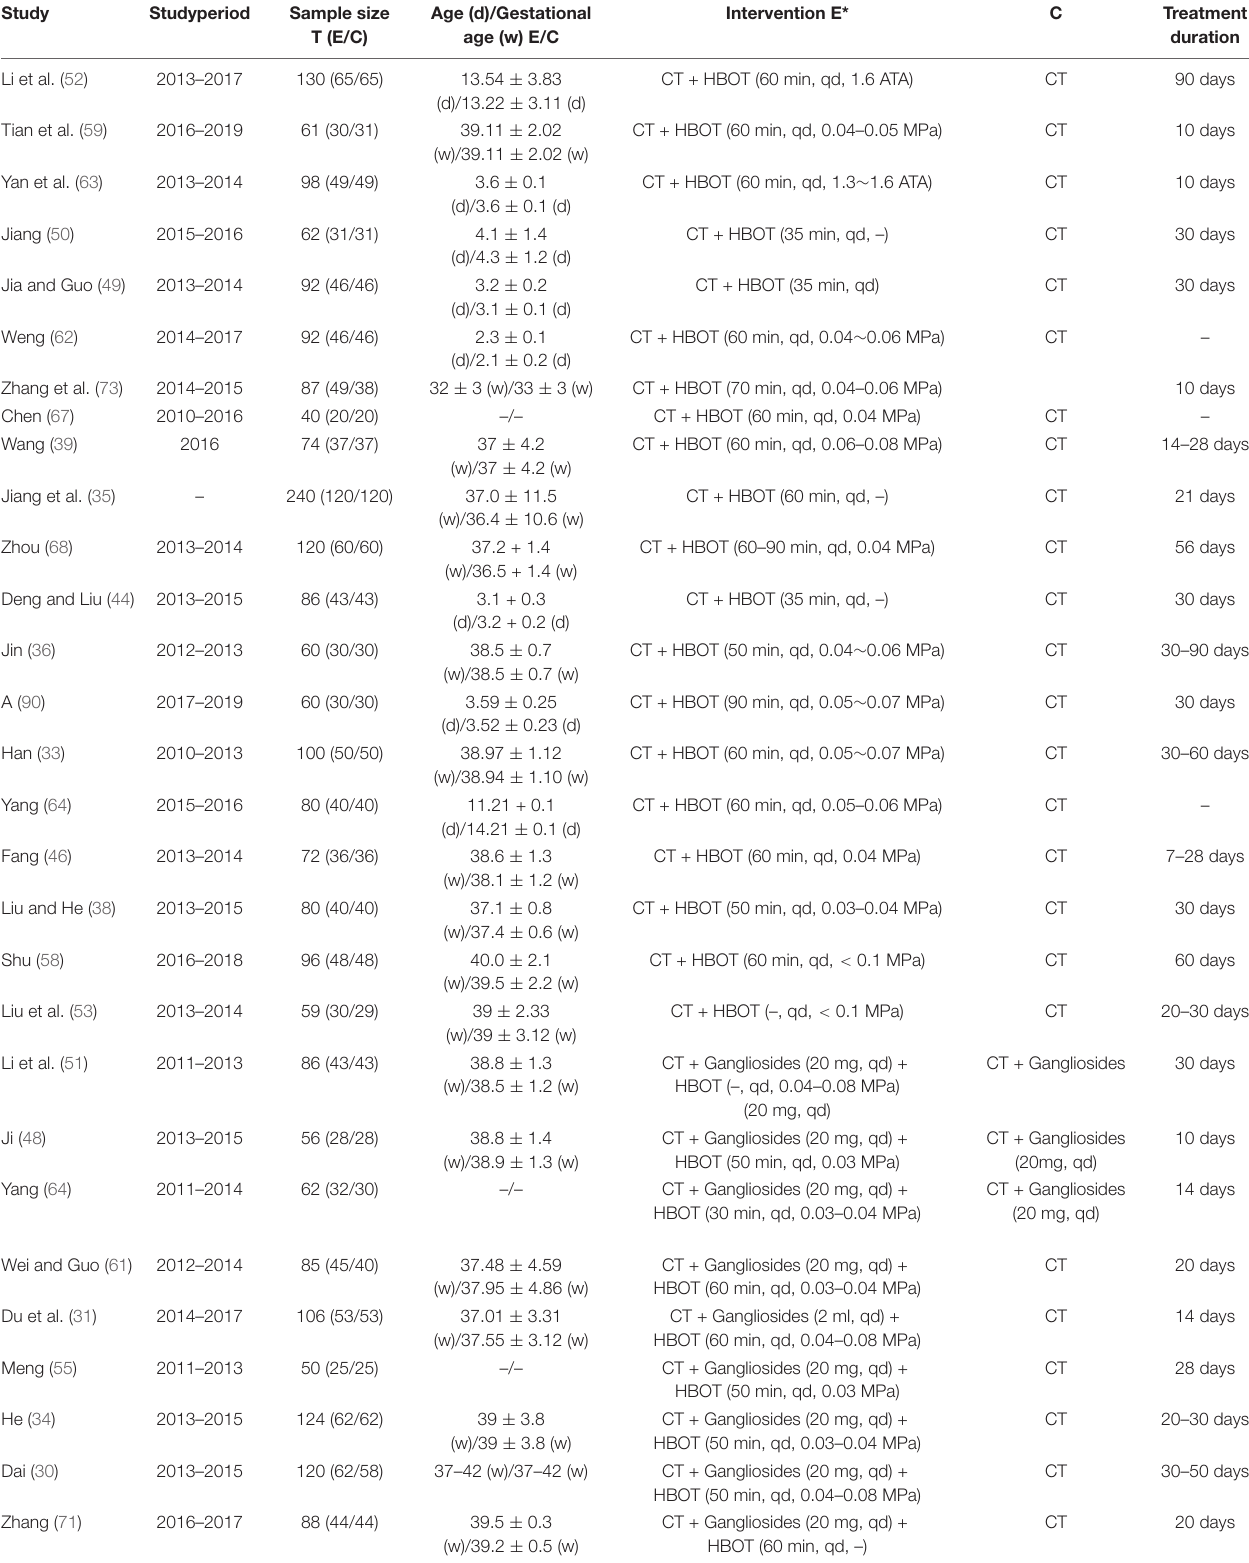
TABLE 1 | Basic features of the studies included in the